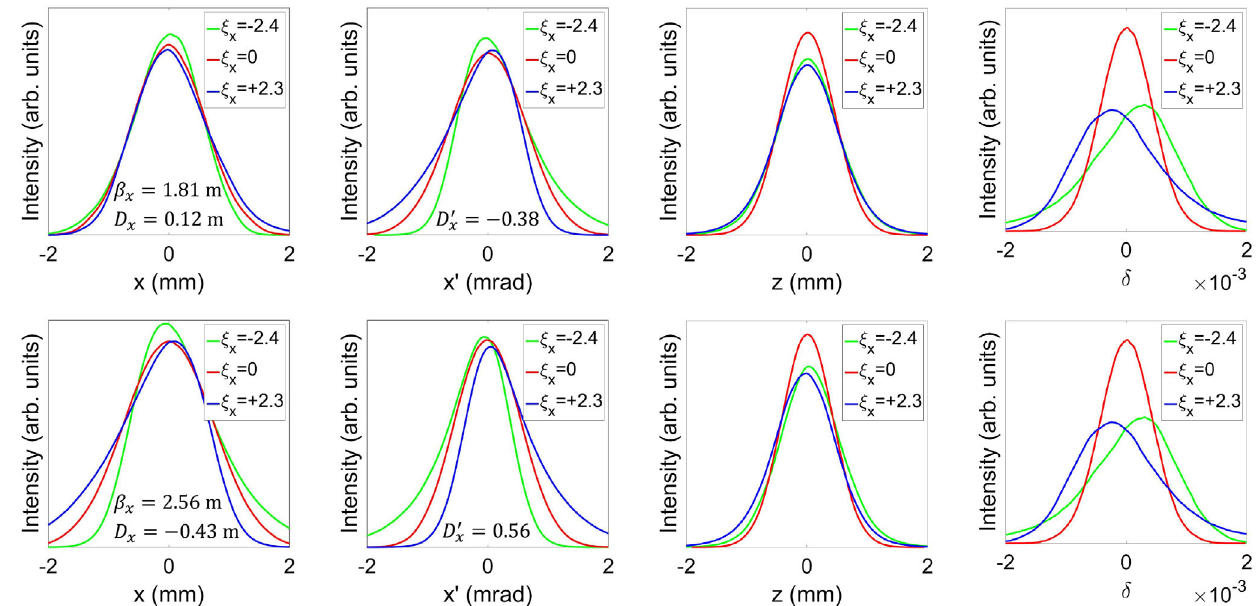
FIG. 9. Energy widening, bunch lengthening and distortion from a Gaussian distribution induced by a nonvanishing horizontal chromaticity. From top to bottom, the particle tracking results for distributions of x , x 0 , z and δ are shown at two dispersive locations in the MLS under three different horizontal chromaticities ξ x . The direction of the long non-Gaussian tail for δ is related to the signs of α and ξ x , while for x and x 0 they are also dependent on D x and D 0 x , respectively. The simulation was conducted using the ELEGANT [31] code with a beam energy of 630 MeV, an rf voltage of 500 kV and the application of α ¼ 1 × 10 − 4 . In each simulation, eight particles were tracked for 5 × 10 6 turns, corresponding to approximately 73 longitudinal damping